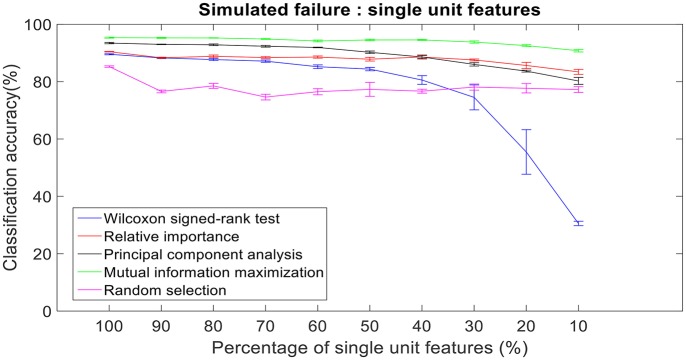
Robustness to simulated failure of units. The plot above shows the cross-validated classification accuracy at various failure levels. Mutual information maximization based feature selection had a classification accuracy of 90.79% with just 10% of the neural units as feature vector. Error bars indicate the standard error of classification accuracy.